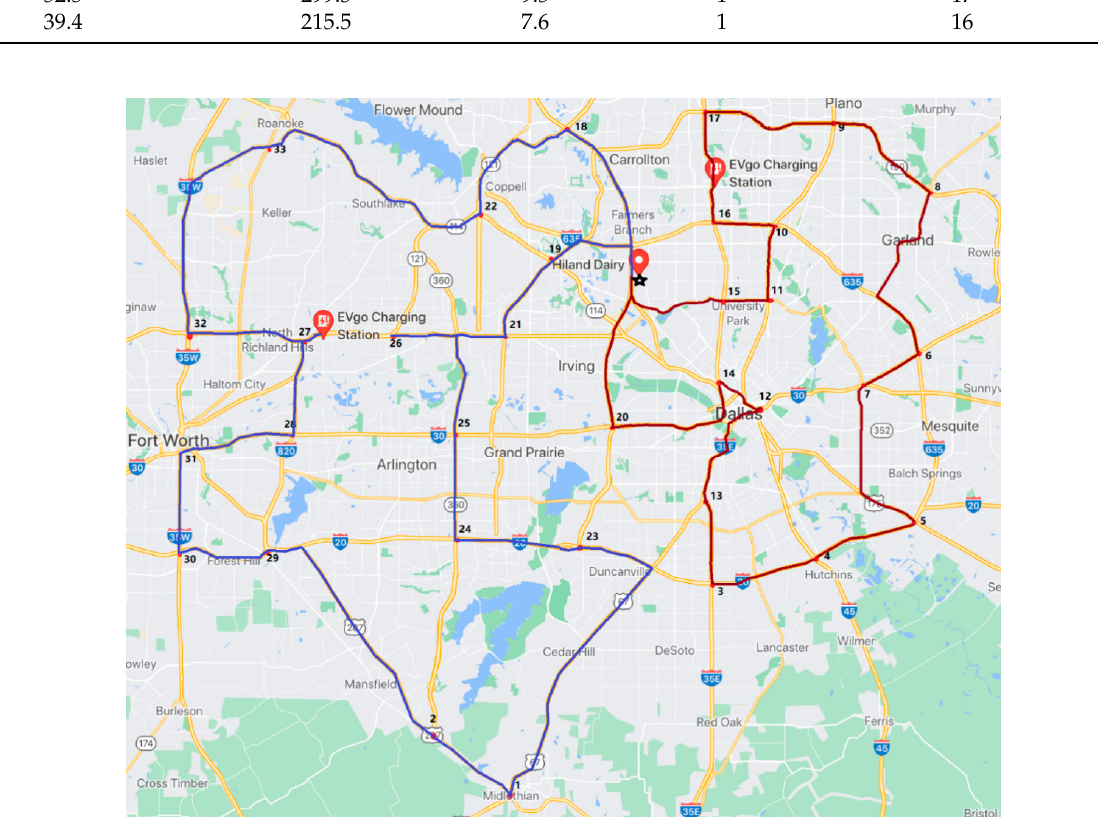
Figure 8. The optimal route diagram.